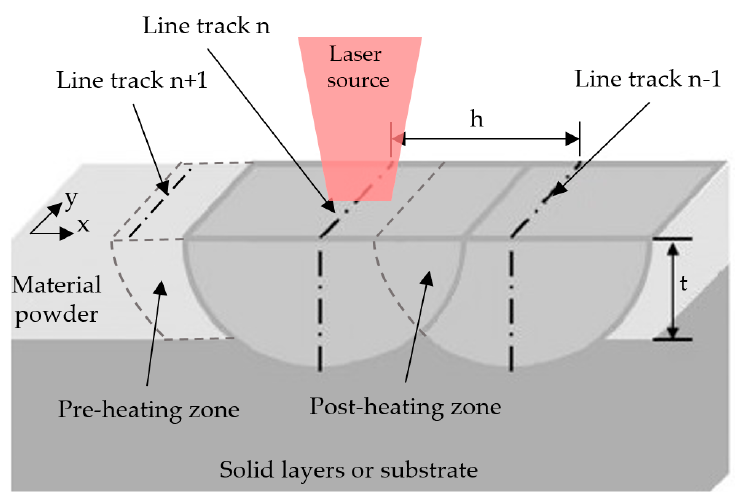
Figure 11. Schematic representation of the hatch overlap effect.